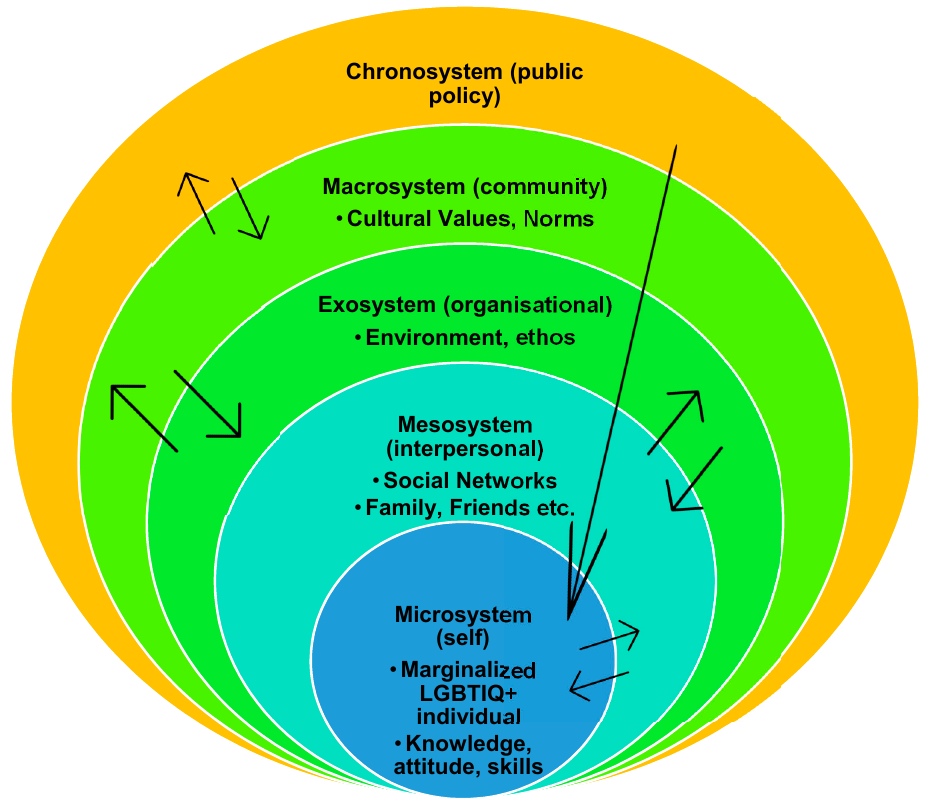
Figure 1. Socioecological theory, IPV and marginalised LGBTIQ people.